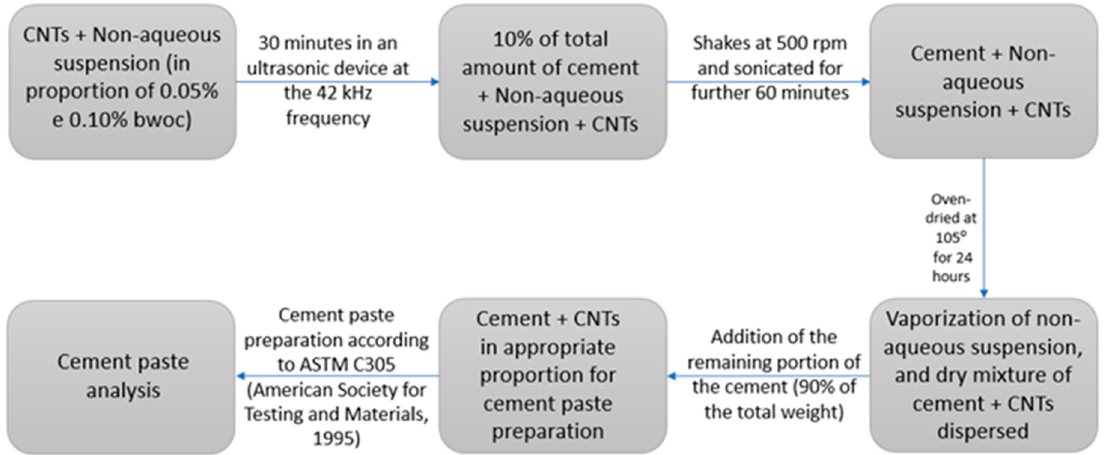
Figure 3. Flowchart of the dispersion process of the CNTs in the anhydrous cement particles in a non-aqueous suspension